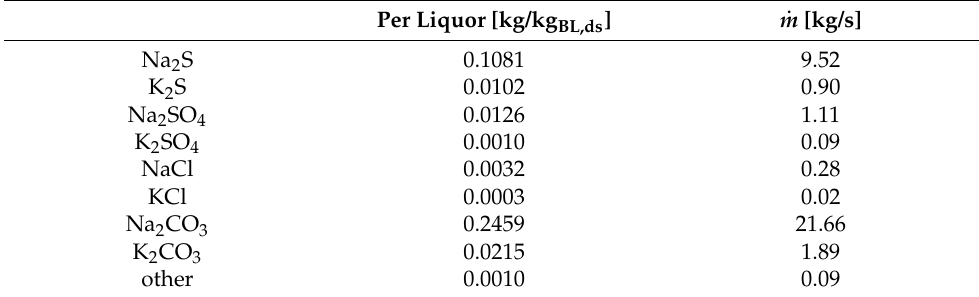
Table A1. Smelt composition, relative to black liquor dry solids, and as mass flow with the smelt.